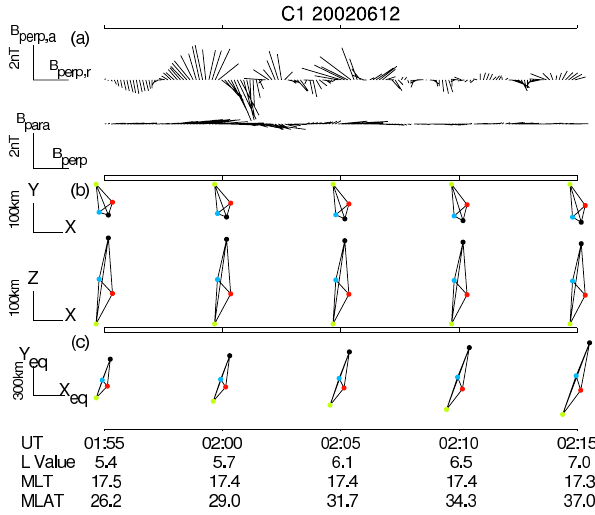
Fig. 8. Cluster data during the outbound plume crossing from 01:55 to 02:15UT on 12 June 2002. The figure shows (a) magnetic fluc- tuations measured by C1 for two perpendicular components (radial and azimuthal components) in the top and magnetic fluctuations for perpendicular and parallel components in the bottom, (b) space- craft constellation projected to the X-Y and the X-Z planes, and (c) spacecraft constellation mapped to the geomagnetic equator. In panel (a) , every one of two data points is plotted in order to increase visibility. In panels (b) and (c) , meaning of each colour is the same as Fig. 4. Spacecraft locations are noted in the bottom of the